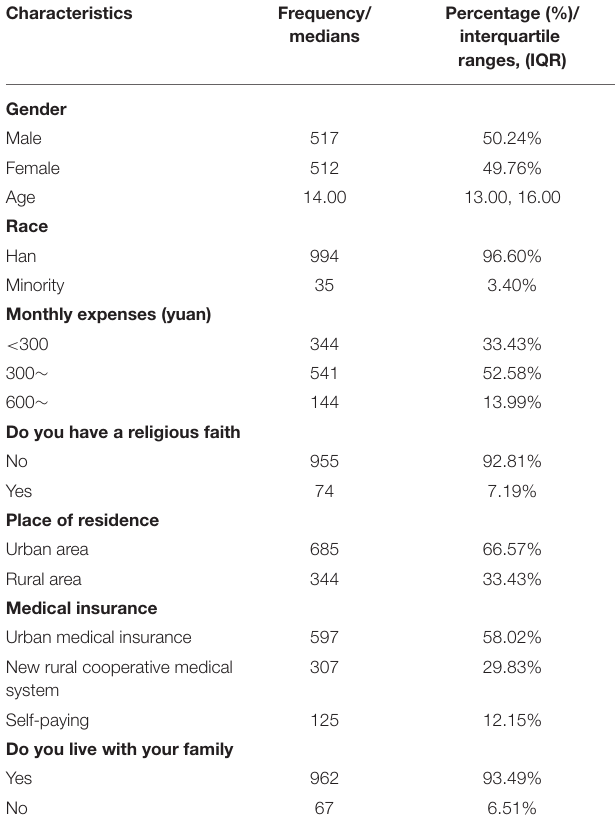
TABLE 1 | The characteristics of the adolescents in the large